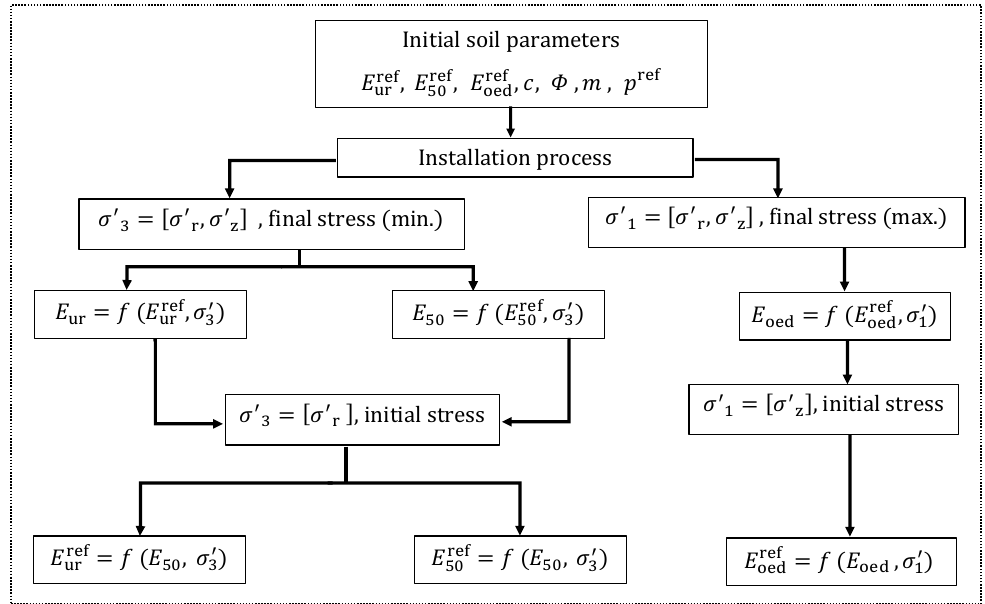
Figure 2. Flow chart for stiffness